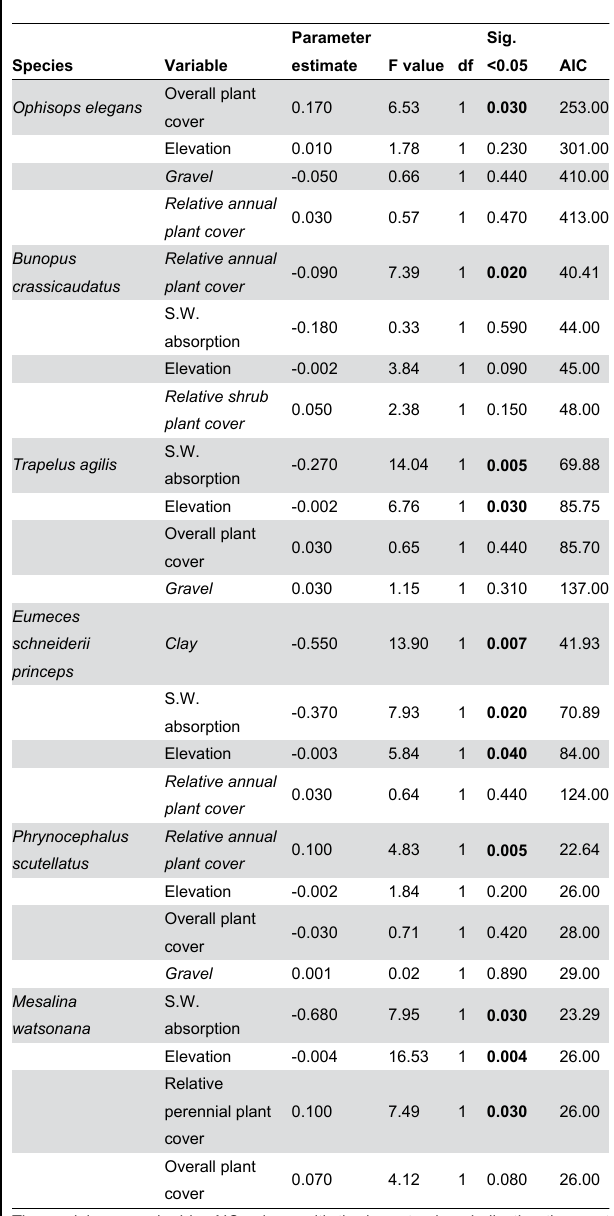
Table 3. Relationship of elevation and species diversity according to regression analysis with quadratic